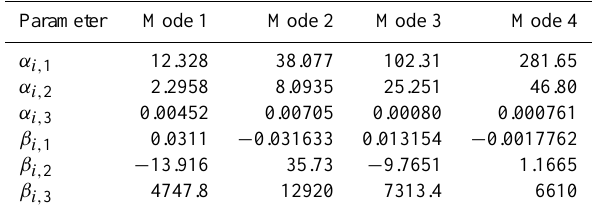
Table 5. Values of parameters inferred from polynomial and expo- nential regressions defining the total particle number and geometric mean diameter of the lognormal modes comprising the size distri- butions as a function of the diatomaceous OC < 0 . 2 µ m content of seawater ( i = mode